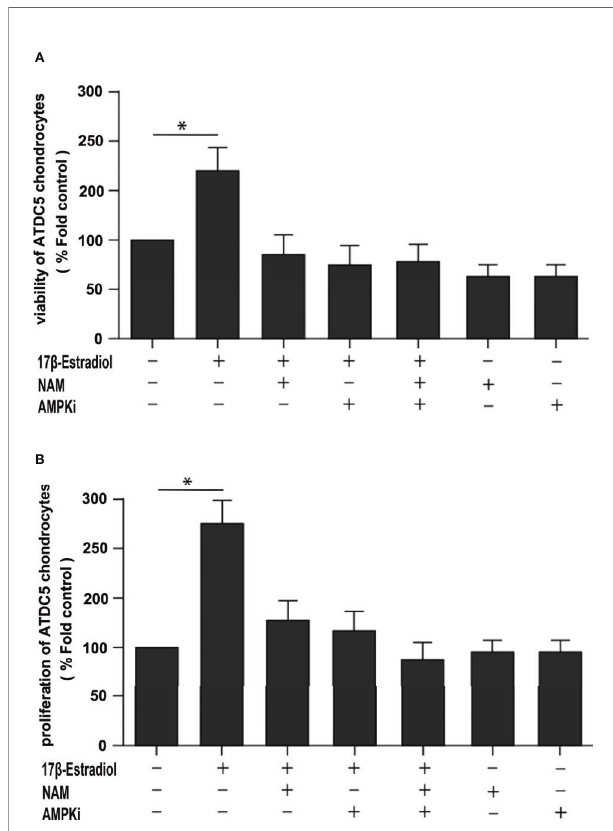
FIGURE 6 | A bene fi cial effect of 17 b -E2 by upregulating mitophagy through the SIRT1-mediated AMPK/mTOR pathway. (A) MTT and (B) bromodeoxyuridine (BrdU) were used to detect the viability and proliferation of ATDC5 chondrocytes. The cells were cultured in the presence or absence of NAM and AMPK inhibitors for 30 min prior to treatment with 17 b -E2 (0 M or 1 × 10 -7 M) 24 h. These experiments were independently repeated 3 times. * P < 0.05 versus the control group indicated a signi fi cant difference.